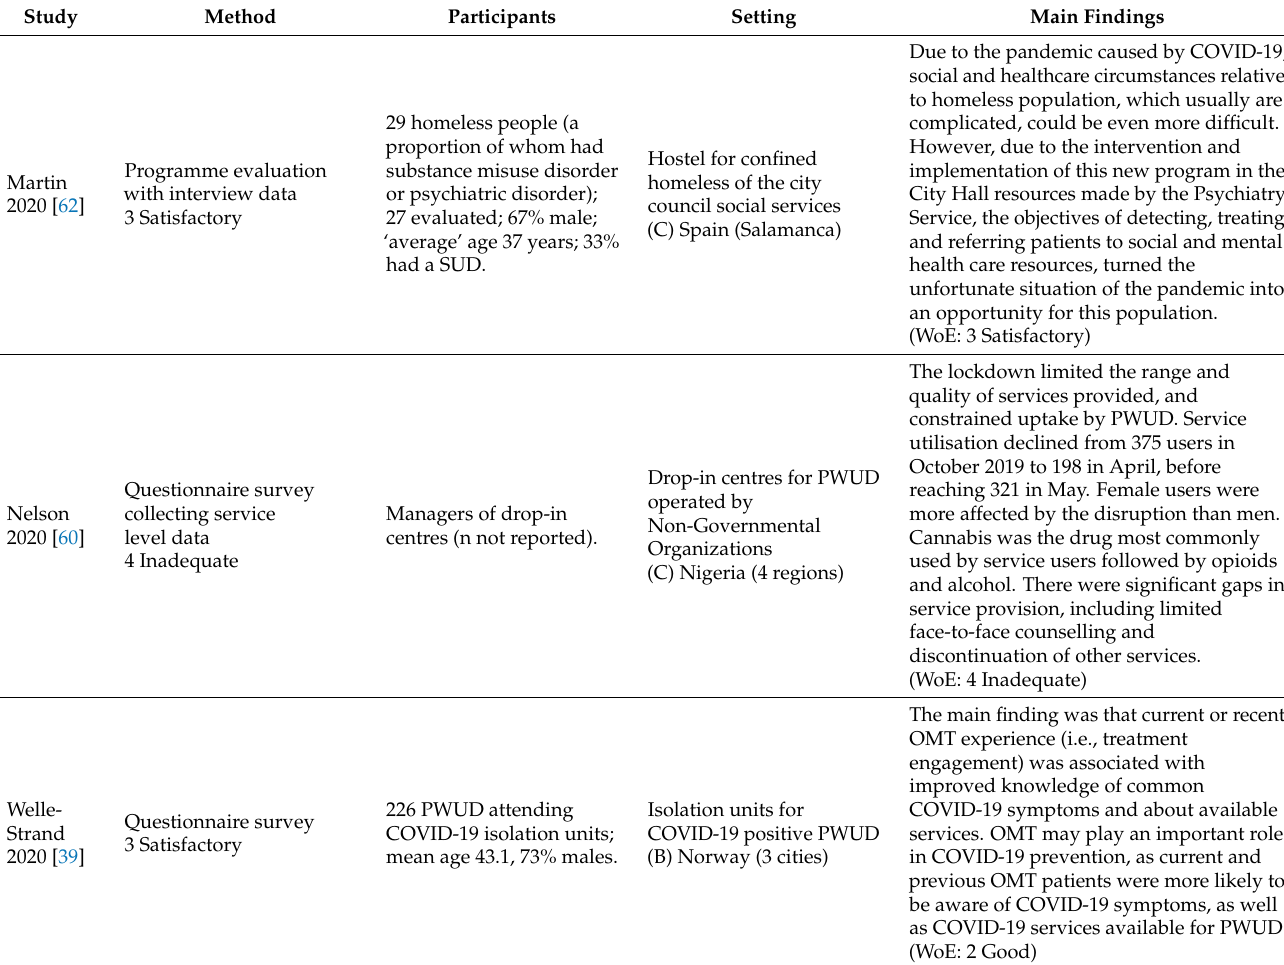
Table 7. Low threshold